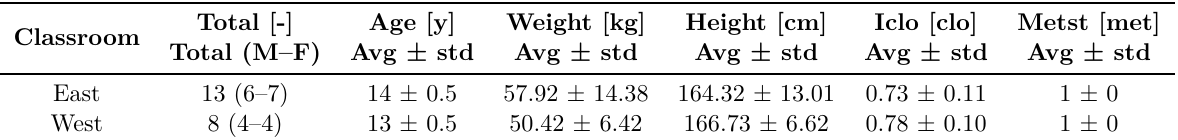
Table 1. Data of the 21 students involved in the